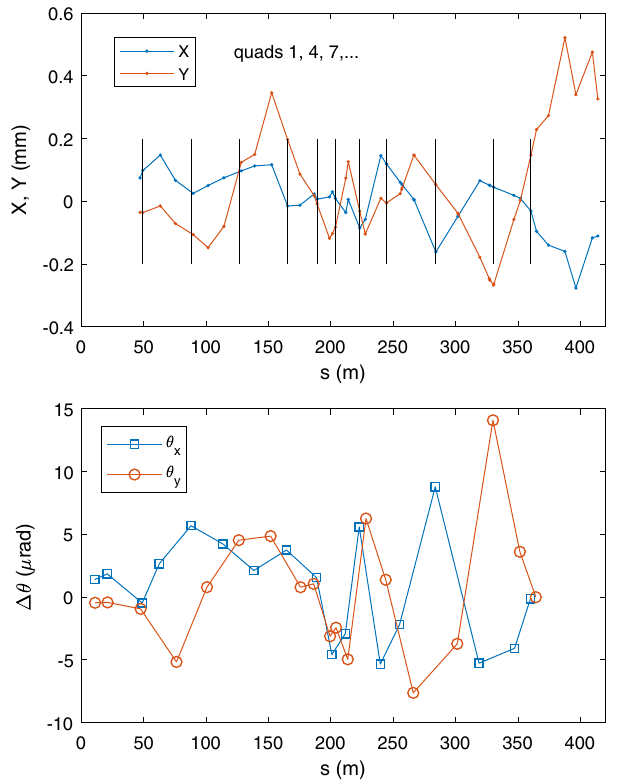
FIG. 4. Top: the beam trajectory after correction of the induced trajectory shift. Quadrupole locations in the group are marked with vertical lines. Bottom: the required kick angle changes on the correctors for the